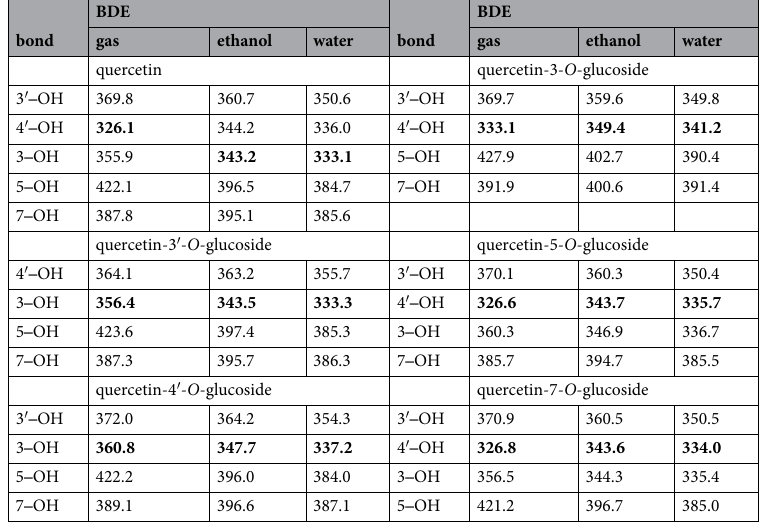
Table 2. O–H bond dissociation enthalpies (BDE) in kJ/mol obtained at M062X/6–311 + G ** level of